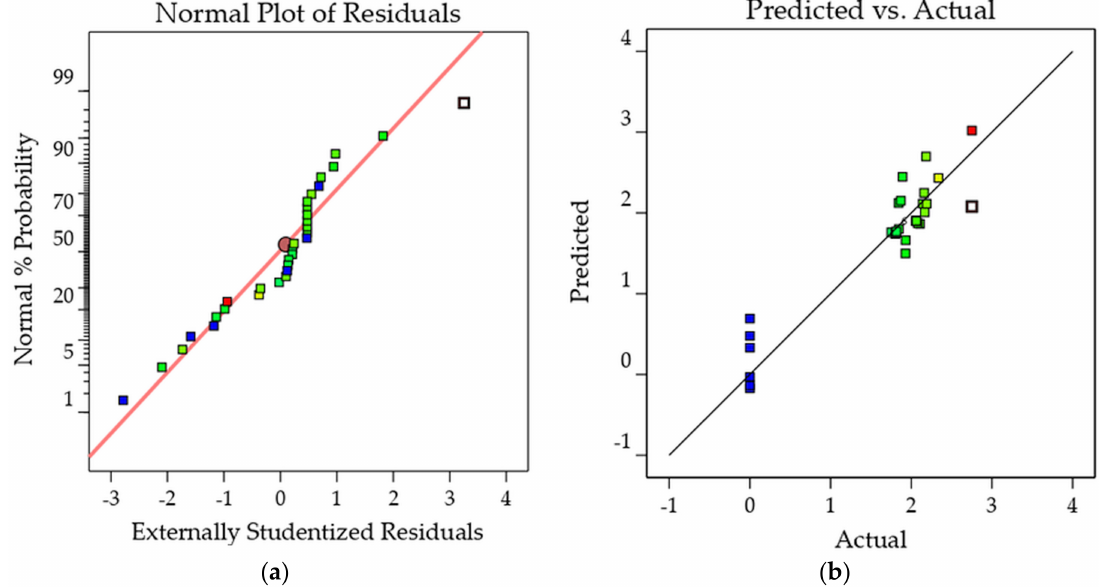
Figure 7. ( a ) Normal plot of residual for MRSA cell inhibition.; ( b ) Predicted vs. actual plot for MRSA inhibition. The color scale shows the value of MRSA in the quadratic model from blue (0.00) to red (2.752). p -values lower than 0.05 illustrate the significance of the model terms. All